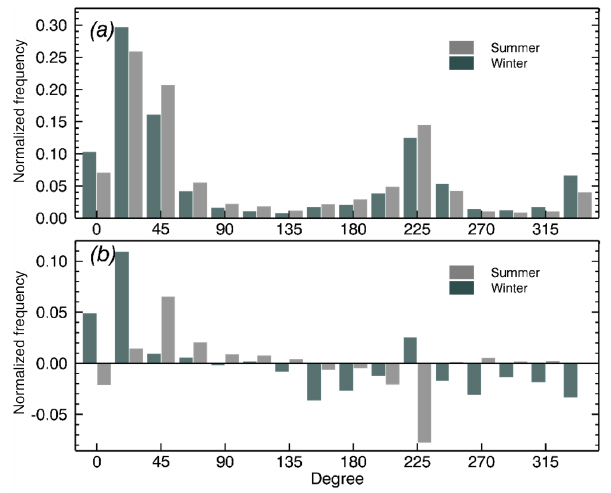
Figure 10. Histogram of normalized frequency for 16 wind direc- tions in (a) the entire period and (b) differences of normalized fre- quency with respect to wind directions between DT and NT (DT– NT) for the summer (light grey) and winter (dark grey)